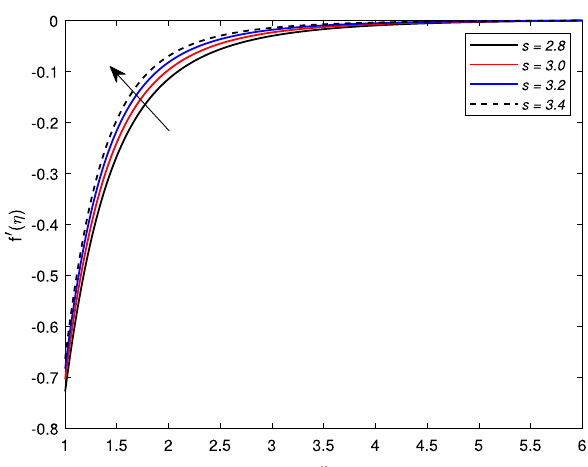
0.2 (contracting = −